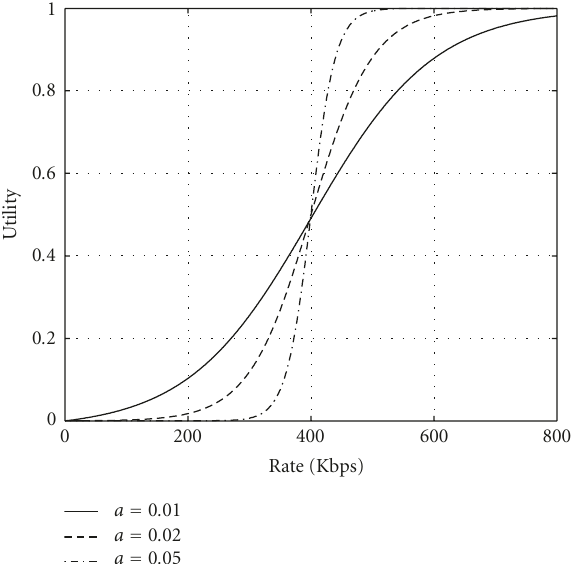
Figure 4: Average utility (sigmoidal